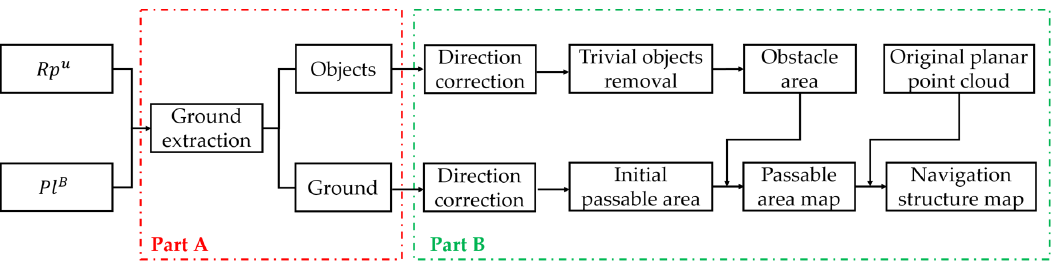
Figure 12. The flow chart of navigation structure map (NSM) construction.